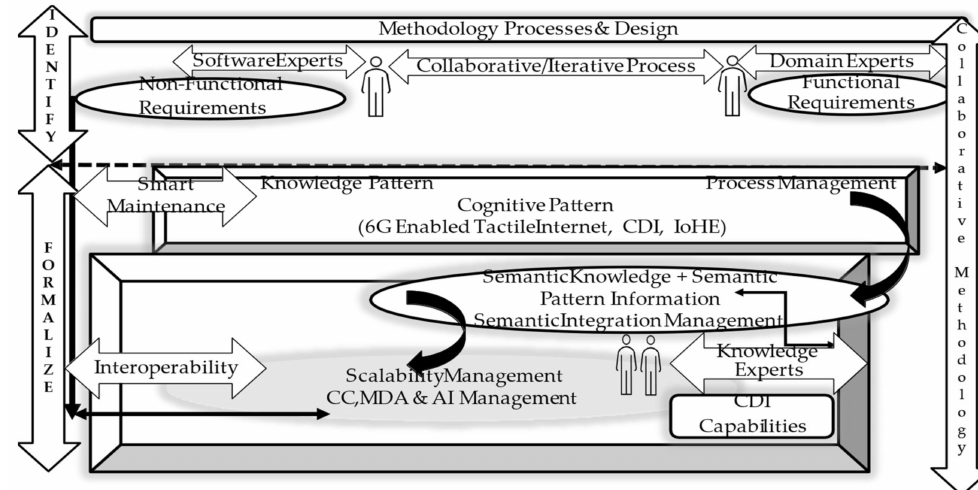
Figure 7. A model driven methodology for the design of 6GCIoHE